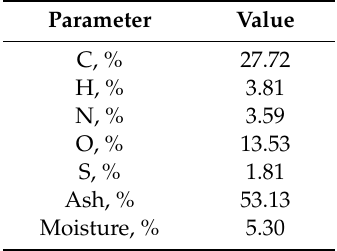
Table 1. Sewage sludge elemental composition and properties (based on